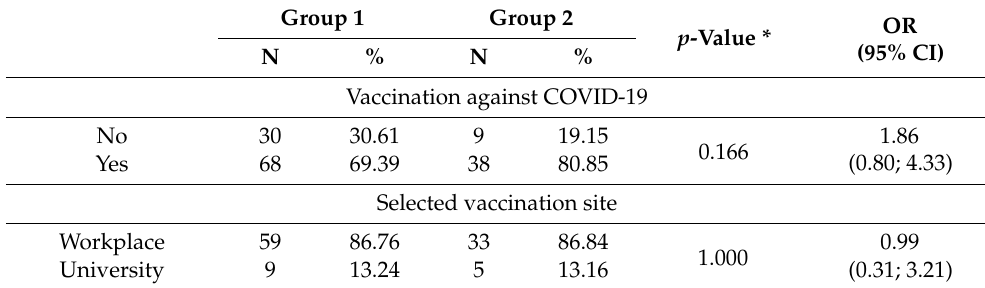
Table 3. Willingness to get COVID-19 vaccine in groups G1 and G2.